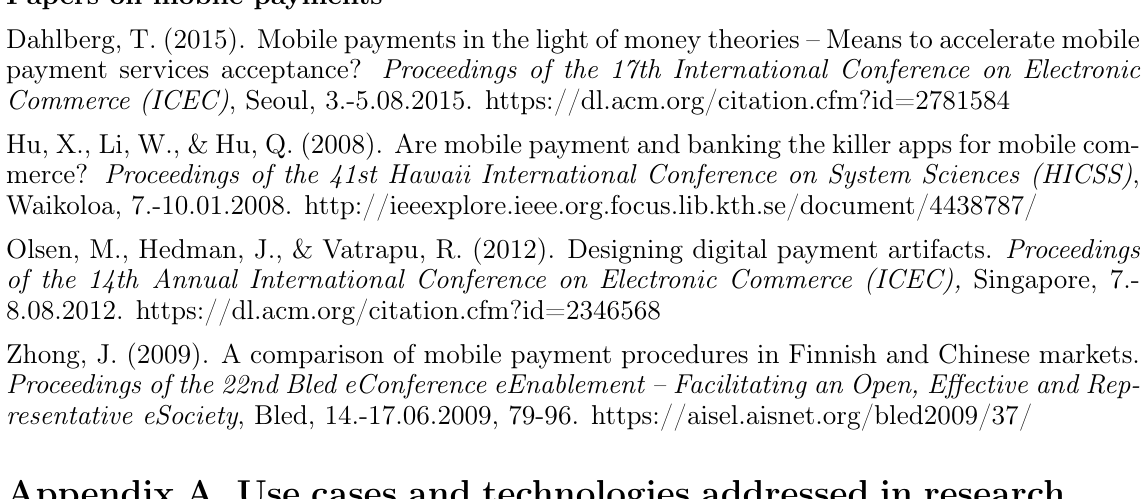
Table A.1. Mobile payment use cases discussed in selected papers.